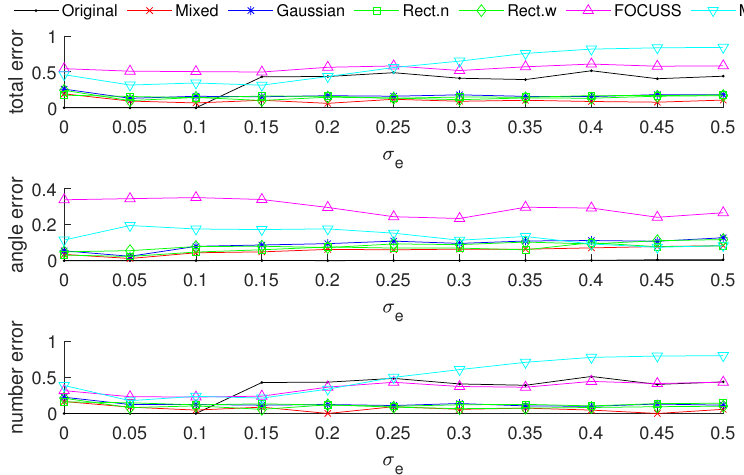
Figure 15. The DOA estimation error in terms of OSPA distance via different subarrays based on an arbitrary array when the prior distribution and the true distribution are both given by N ( 500,50 2 ) and N ( 1500,50 2 ) .